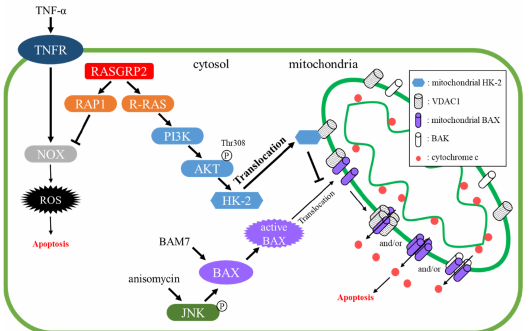
Figure 3. Proposed model for apoptosis suppression via the RAP1 and R-RAS pathways by RASGRP2. TNF- α : tumor necrosis factor- α , TNFR: tumor necrosis factor receptor, NOX: NADPH oxidase, ROS: reactive oxygen species, RASGRP2: RAS guanyl nucleotide releasing protein 2, PI3K: phosphoinositide 3-kinase, JNK: c-jun N-terminal kinase, HK-2: hexokinase-2, VDAC: voltage-de- pendent anion channel, Thr: Threonine, P: phosphorylation. 7. Suppression of Vascular Hyper-Permeability by RASGRP2 Signaling in Vascular Endothelial Cells Vascular hyperpermeability caused by various factors, such as advanced glycation end products (AGEs) and lipopolysaccharides, affects the onset and exacerbation of dis- ease [48–51]. Maintenance of vascular permeability is regulated by adhesion factors be- tween vascular endothelial cells, including adherens junctions (AJs), tight junctions (TJs), and gap junctions, which consist of vascular endothelial (VE)-cadherin and its associated α -, β -, and p120-catenin adhesion complexes; and occludin; claudins; junctional adhesion molecules; and associated zonula occludens (ZO)-1, -2, and -3 proteins [52]. RAP1 activated by RASGRP2 suppressed vascular hyperpermeability through the NOX-ROS pathway by AGEs without enhancing the basal barrier function. R-RAS acti- vated by RASGRP2 partially suppressed vascular hyperpermeability through the non- ROS producing pathway by AGEs. The suppression by RASGRP2 was ultimately due to protection against perturbation of the VE-cadherin protein, but not the ZO-1 protein [53]. Therefore, it has been suggested that RASGRP2 plays an important role in vascular per- meability (Figure 4).